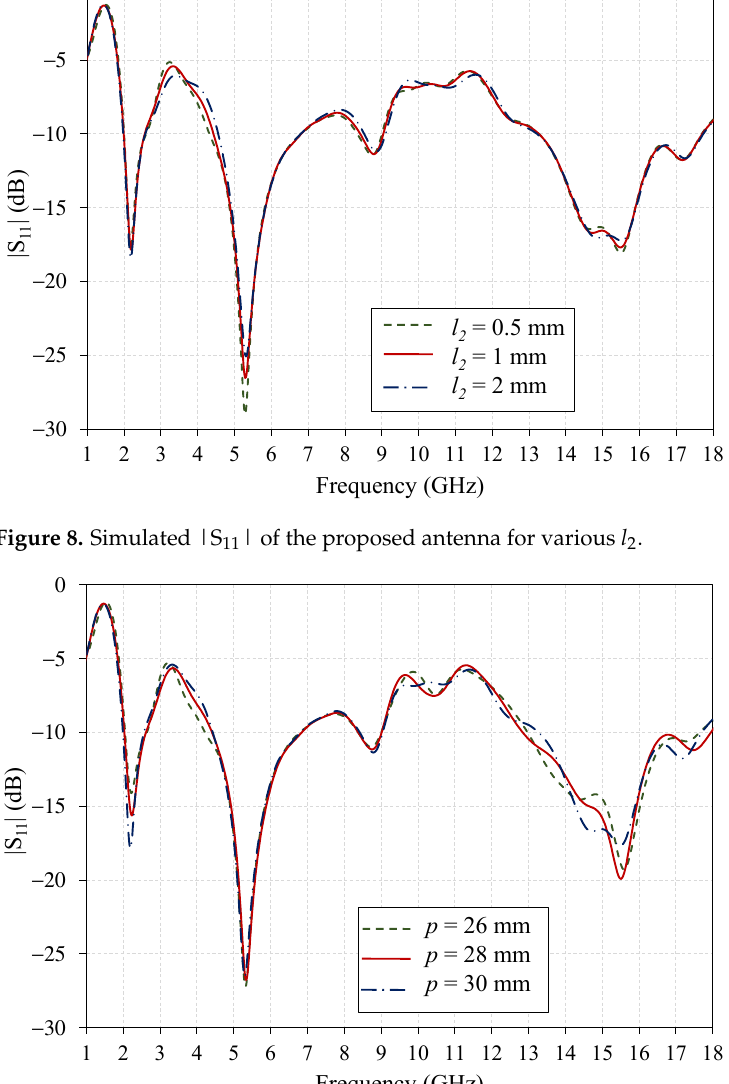
Figure 9. Simulated |S 11 | of the proposed antenna for various p .